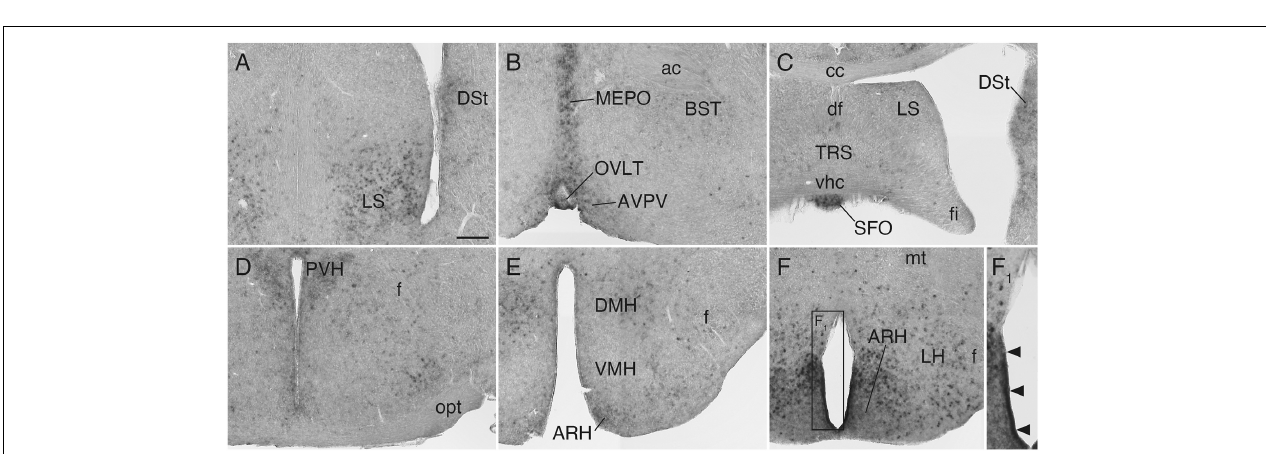
FIGURE 4 | Sulf1 mRNA expression in the thalamus. (A–D) Sulf1 was detected in the midline thalamic nuclei, including the paraventricular (PVT), intermediodorsal (IMD), and reuniens (RE) nuclei. It was also seen in the intralaminar nuclei, including the central medial (CM), paracentral (PCN), and parafascicular (PF) nuclei. (A 1 − D 1 ) Show the enlarged images in the boxed areas in (A–D) , respectively. AD, anterodorsal nucleus; CLA, claustrum; CP, choroid plexus; Cx, cerebral cortex; EPd, endopiriform nucleus dorsal part; f, fornix; fr, fasciculus retroflexus; HPF, hippocampal formation; mt, mammillothalamic tract; PVH, paraventricular hypothalamic nucleus; TS, posterior tail of the striatum. The scale bars indicate 500 µ m (A–D) and 200 µ m (A 1 –D 1 ) . Approximate AP levels from the bregma (in mm) are –0.5 (A) , –1.0 (B) , –2.0 (C) , and –2.5 (D) .